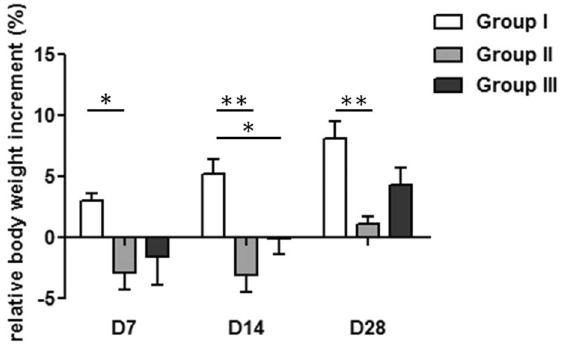
Fig. 1. Relative changes in body weight. The histogram shows the relative changes in body weight in the experimental groups over time. A significant weight loss was measured in group II versus the control group I over time. Group III showed a significant body weight loss at day 14 after implantation compared to group I. Group III recovered body weight starting from the second week after surgery (two-way ANOVA, **P , 0.01, *P , 0.05; n=8).